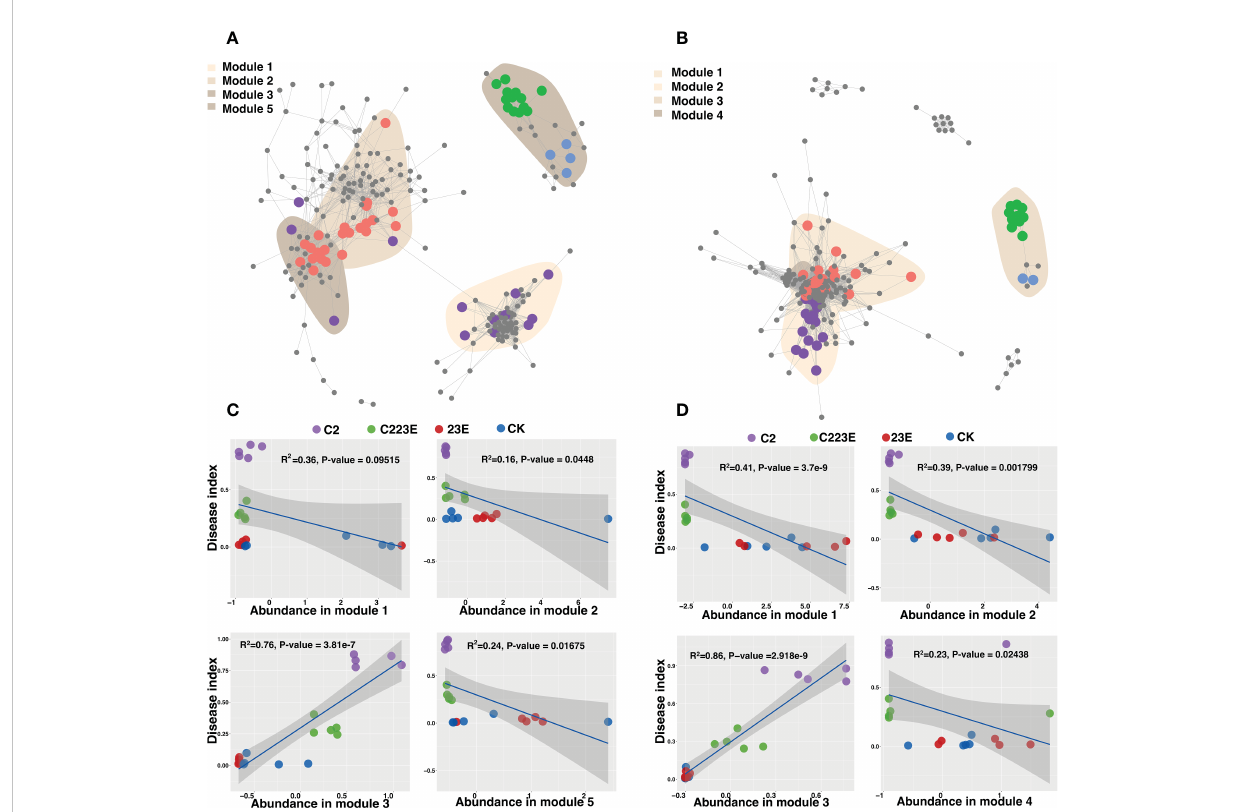
FIGURE 5 Co-occurrence patterns of phyllosphere bacterial communities. The co-occurrence network showed the connectivity between the core phyllosphere epiphytic ASVs (A) and phyllosphere endophytic ASVs (B) . (R > 0.7, P < 0.05; Indicated with gray lines). Gray nodes represents ASVs that were not sensitive to differences in different treatments; areas of different colors represents aggregation modules of phyllosphere dominant bacterial communities of different treatments; nodes of different colors corresponds to key dominant bacterial communities of different treatments. The lines between the nodes represents the correlation between the connected ASV. Regression of disease index and abundance of ecological modules in epiphytic (C) and endophytic (D) co-occurrence networks. CK, Control; C2, Xoo strain alone; 23E, Xoo phages (J2+J3+E); C223E, Xoo strain C2 + Xoo phages